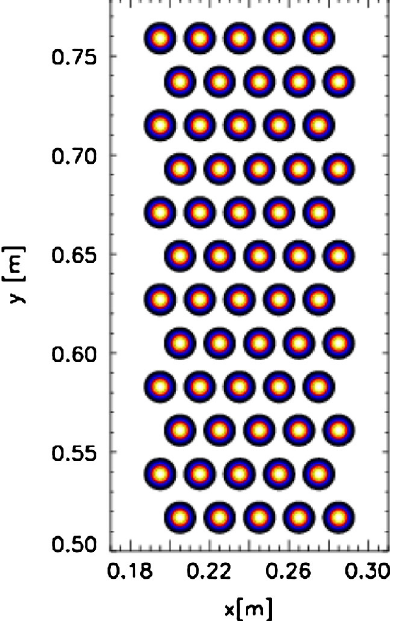
FIG. 11. Zoom of one beamlet group of the phantom with the criss-cross. Each horizontal line of beamlets is shifted alterna- tively by þ 5 mm and (cid:1) 5 mm .